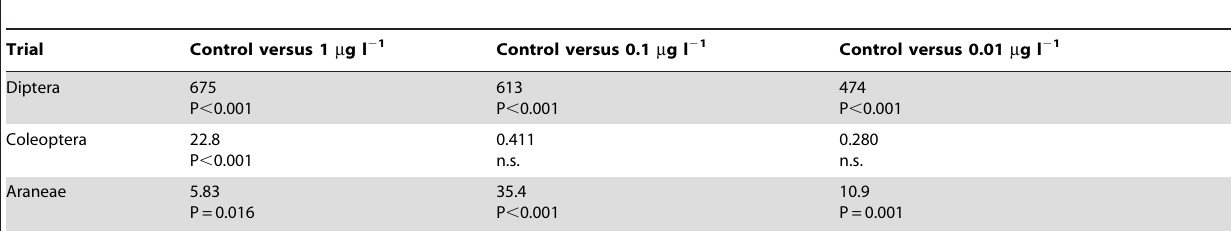
Table 1. Wald x 2 values and significance for the effects of imidacloprid on catch of arthropod taxa (D.F=1 in all cases).